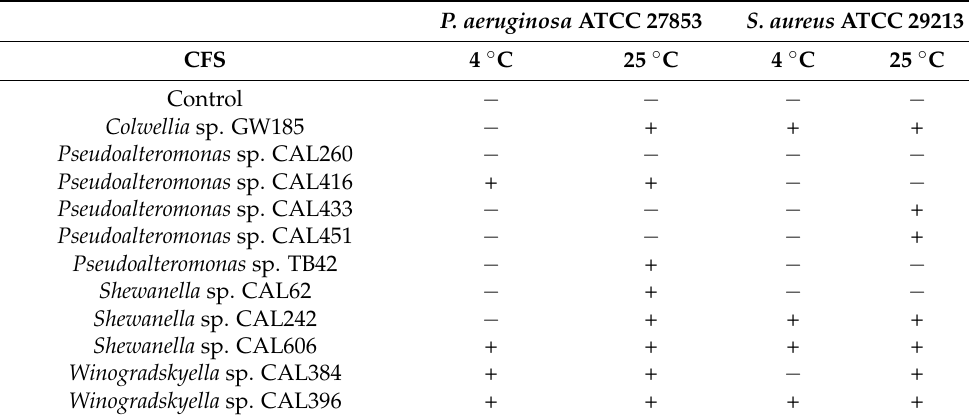
Table 3. Inhibition of Pseudomonas aeruginosa and Staphylococcus aureus adhesion to polystyrene surfaces in absence (Control) or pre-coated with CFSs from Antarctic sponges-associated bacteria obtained after incubating at 4 ◦ C (CFS 4 ◦ C ) or 25 ◦ C (CFS 25 ◦ C ), after a 18 h